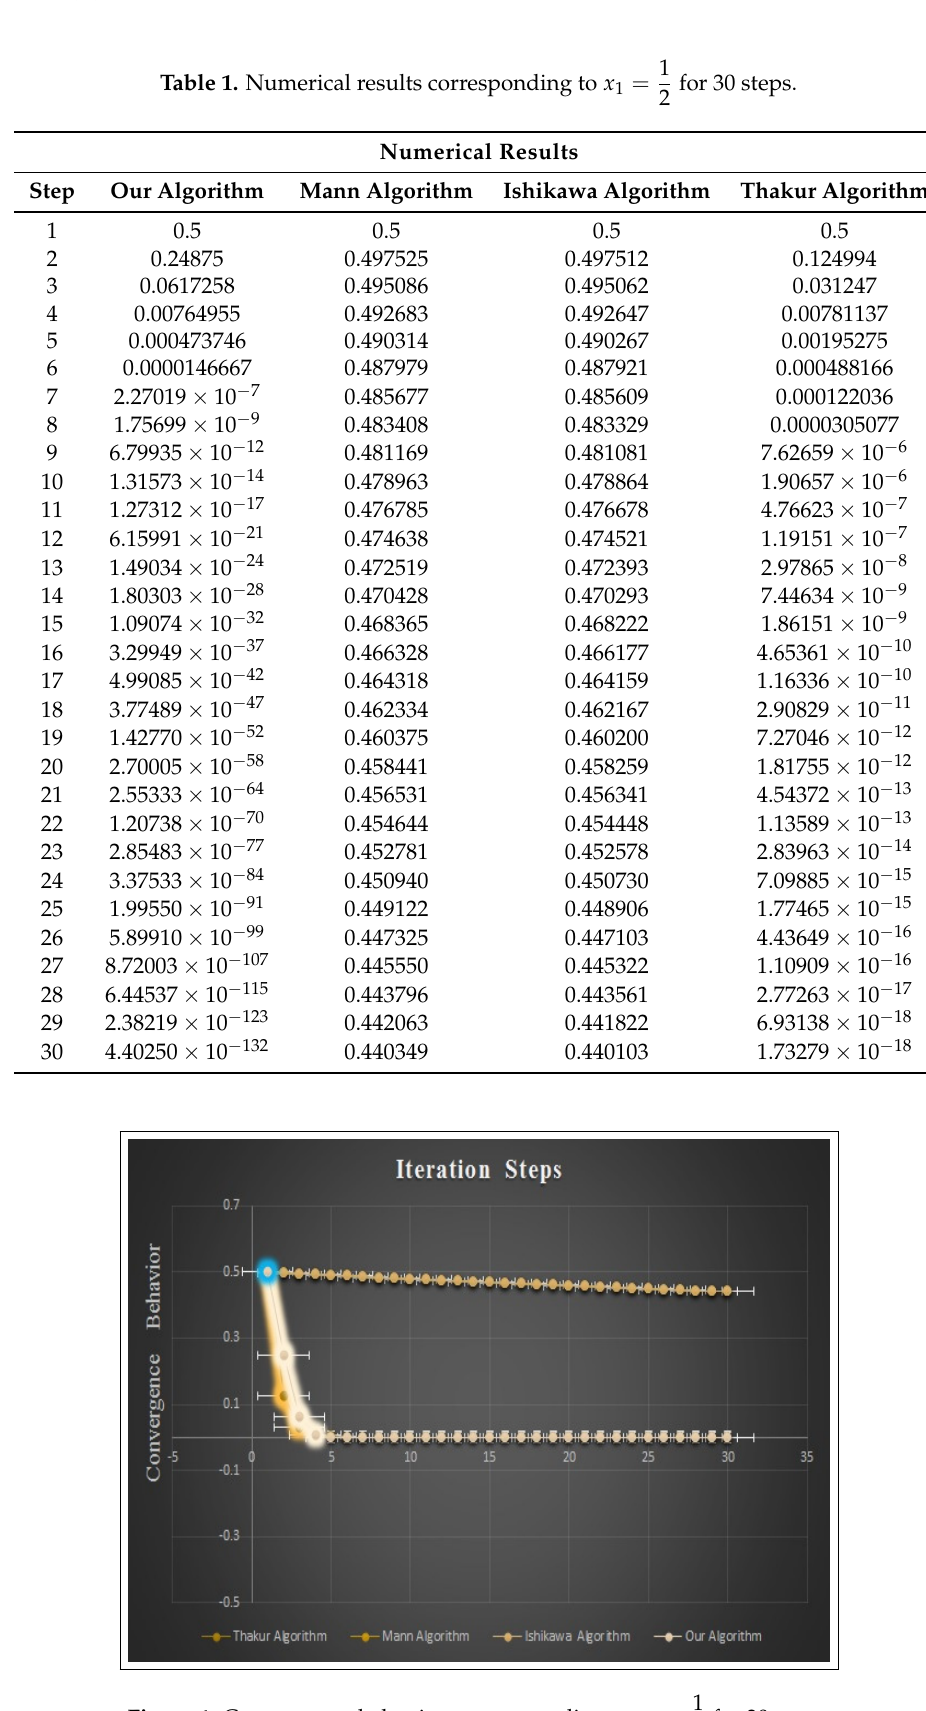
Figure 1. Convergence behaviors corresponding to x 1 =